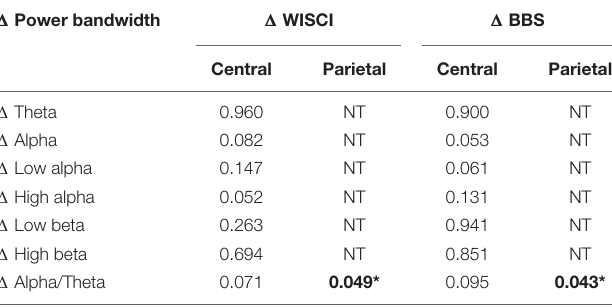
TABLE 3 | Changes in EEG predicted by improvement in functional